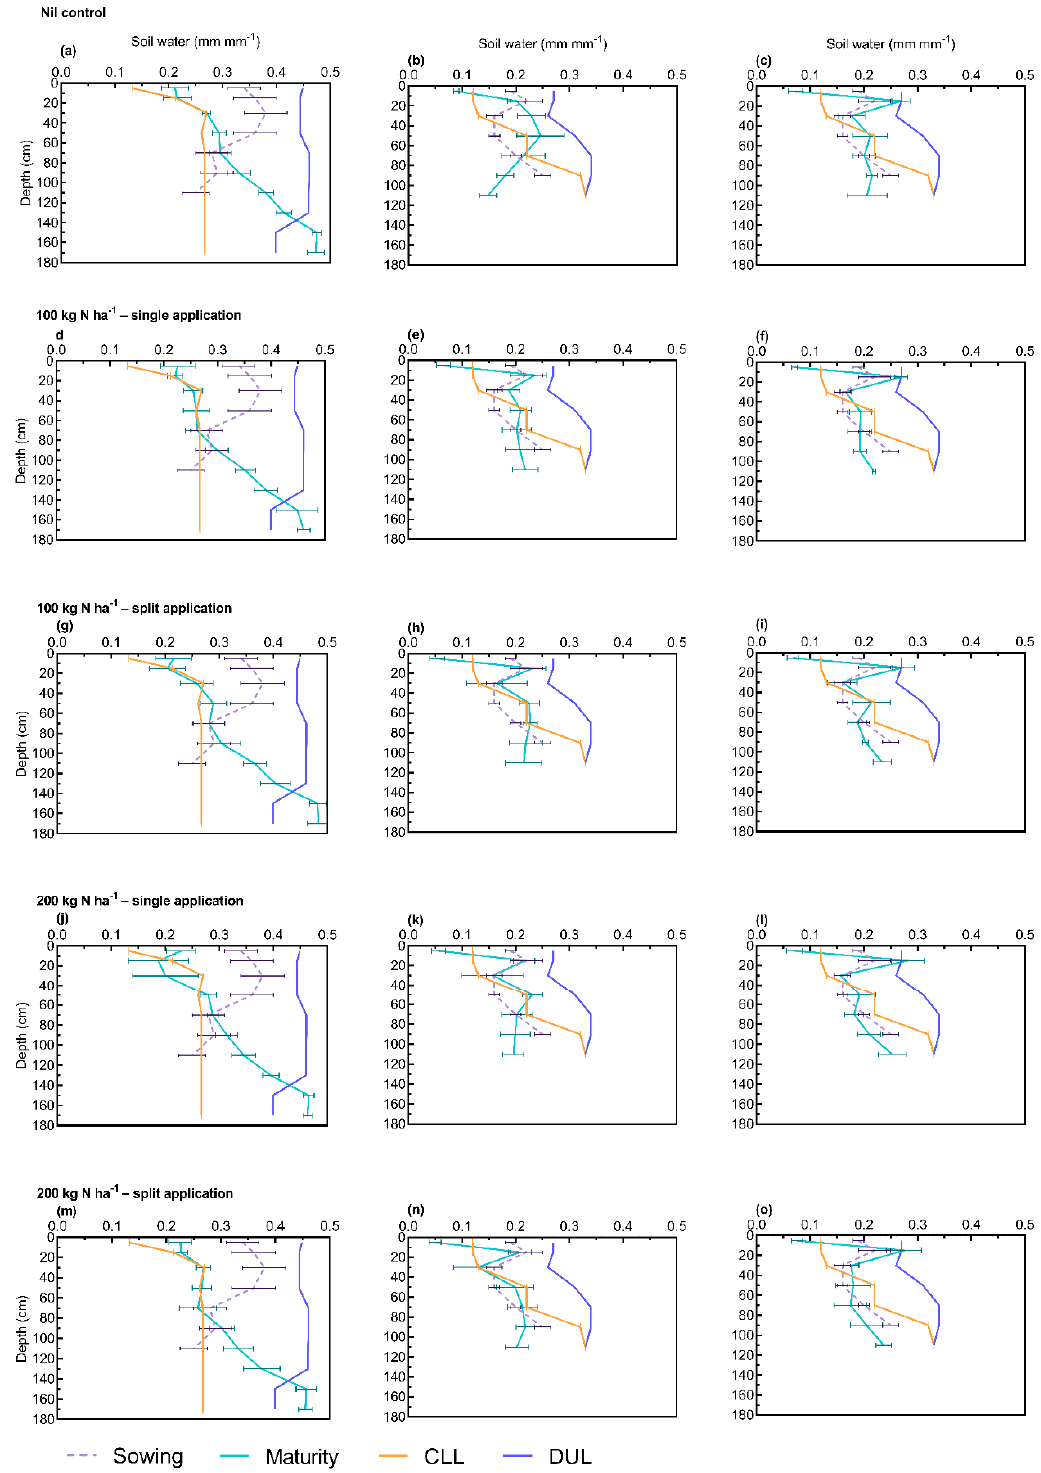
Figure 4. Soil water distribution in profile at sowing and maturity for Tarlee rainfed ( a , d , g , j , m ), Roseworthy irrigated ( b , e , h , k , n ) and Roseworthy rainfed ( c , f , i , l , o ) for different N regimes of 0, 100 single, 100 split, 200 single and 200 split kg ha − 1 N applications, respectively. CLL and DUL are the crop lower limit and drainage upper limit for water extraction from the APSoil data base. Mudla Wirra profile (profile CL028) used for Roseworthy and site the Navan West profile (No. 281) was used for